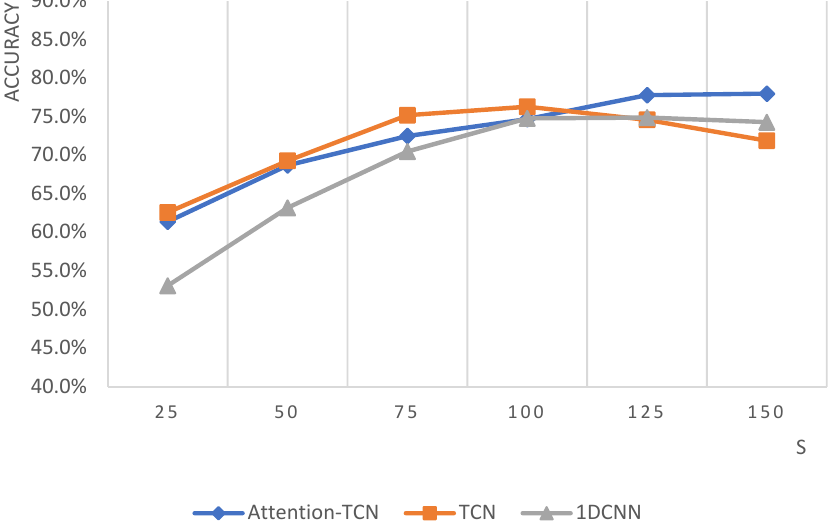
Figure 10. Accuracy of three network migration learning tests.